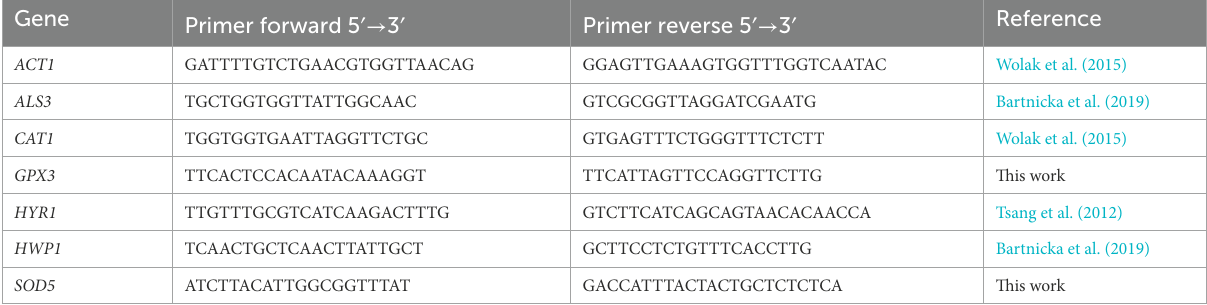
TABLE 1 The list of primers used for quantification of genes for: ACT1 – actin; ALS3 – agglutinin-like protein 3; CAT1 – catalase; GPX3 – glutathione peroxidase; HYR1 – hyphally regulated cell wall protein 1; HWP1 – hyphal wall protein 1; SOD5 – superoxide dismutase 5. Gene Primer forward 5 ′ → 3